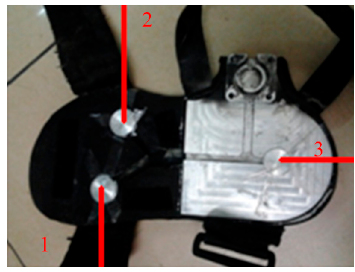
Figure 3. The placement of GRF sensors in the wearable shoe. Two GRF sensors are arranged on the forefoot and one sensor is placed on the heel. The labels 1 , 2 and 3 represent the three sensors. The GRF sensor has a sensing area of 4.52 cm 2 and has a measurement ranging from 0 kg to 100 kg. MEMS-based AHRS sensors (AHRS II, SkyLark, HongKong, China) are used to collect the